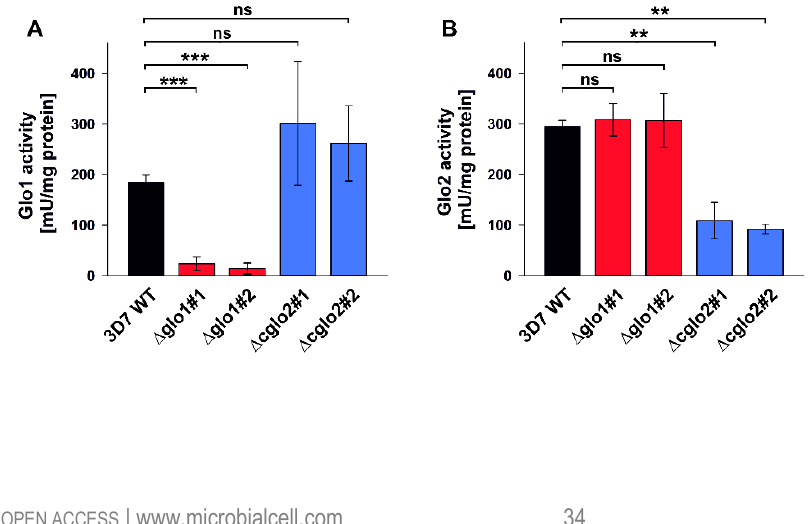
FIGURE 3: Glyoxalase activity mea- surements of P. falciparum knockout strains 3D7Δglo1 and 3D7Δcglo2